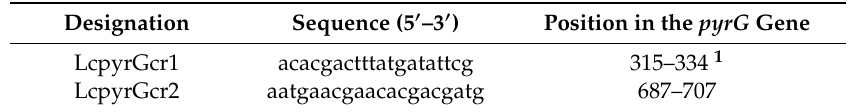
Table 1. Sequences of the protospacers designed in the study and positions of the corresponding regions in the Lichtheimia corymbifera pyrG